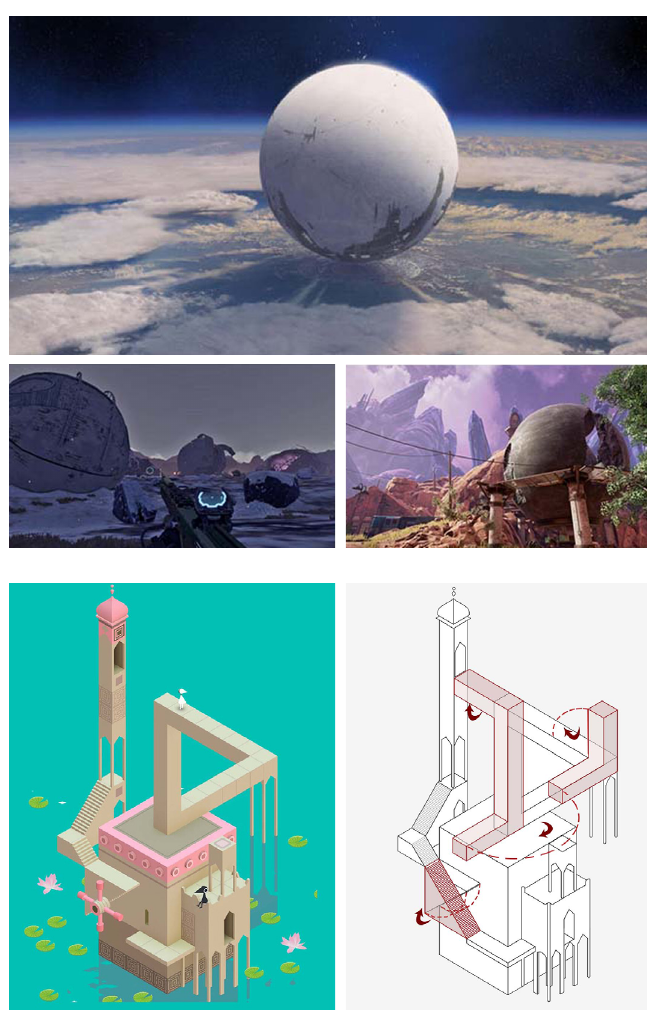
Fig. 8 From top to bottom right: